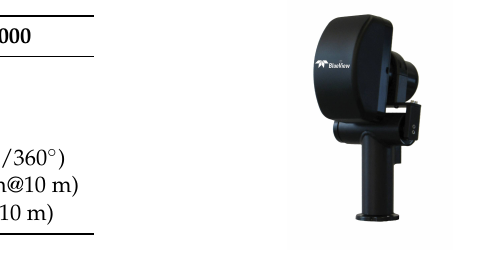
Figure 3. Characteristics and photograph of the Blueview (cid:114) BV5000 MSS.